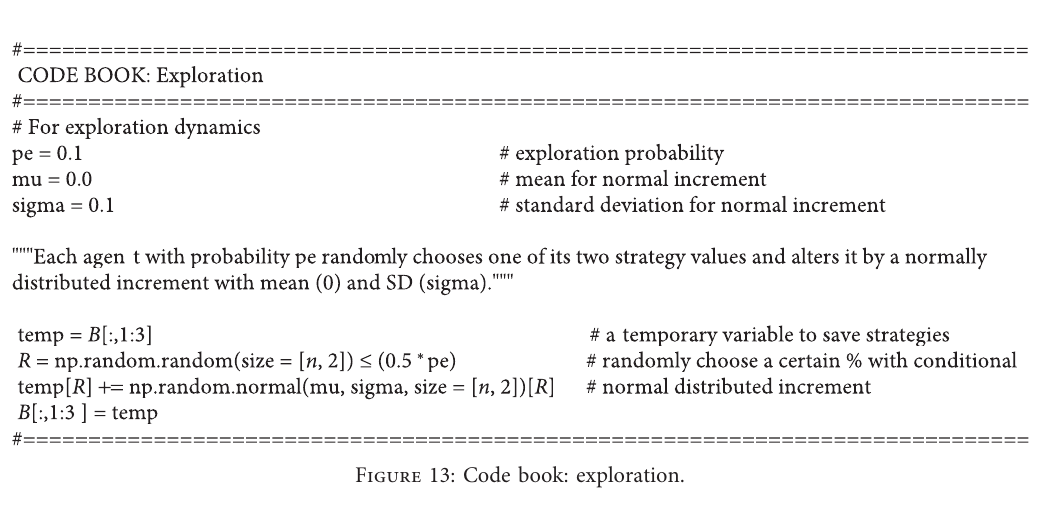
Figure 12: Code book: imitation.